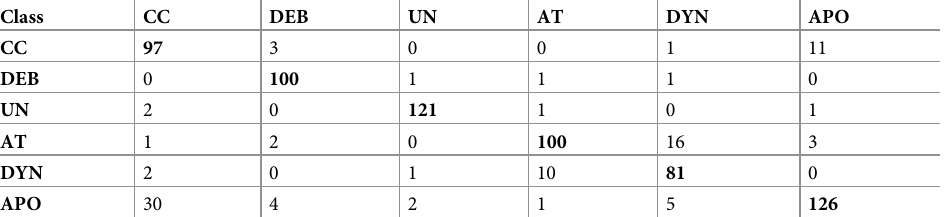
Table 9. Confusion matrix for the classification of the 724 real hESC images using the CNN architecture of Dee- phESC 2.0. Class CC DEB UN AT